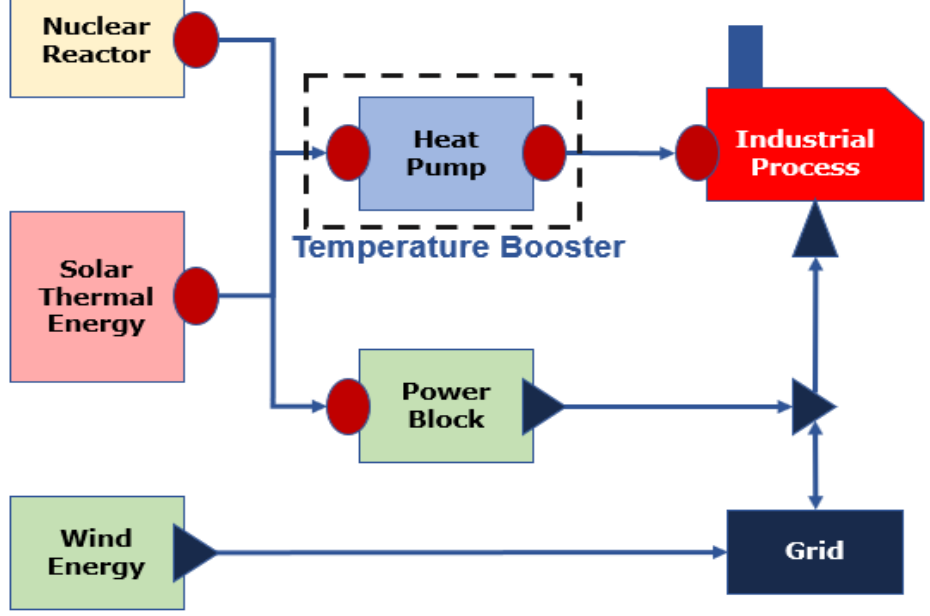
Figure 1. Example of Integrated Energy System.